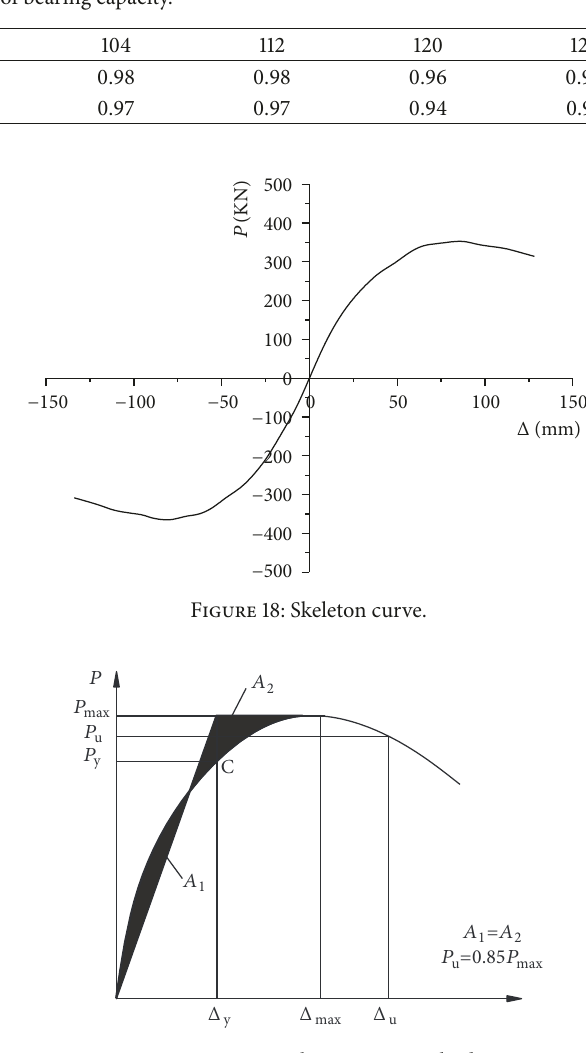
Figure 19: Equivalent energy